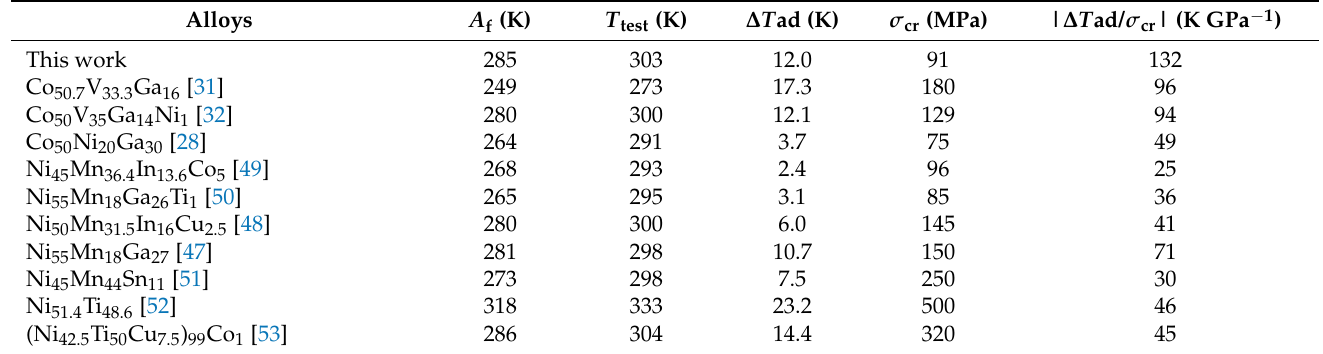
Table 1. The values of | ∆ T ad / ∆ σ cr | for the present textured Co 51.6 V 31.4 Ga 17 alloy and some typical elastocaloric